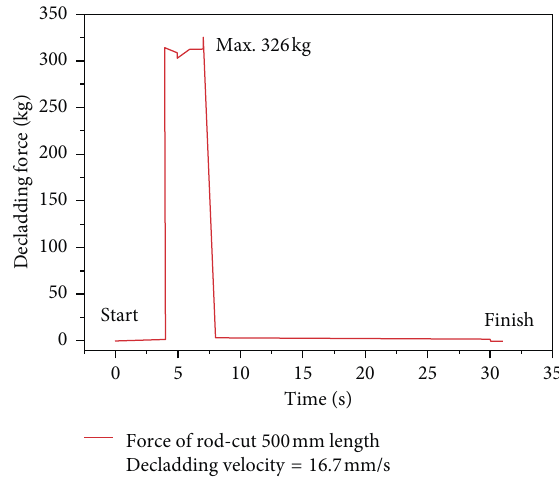
Figure 24: Slitting force and velocity of